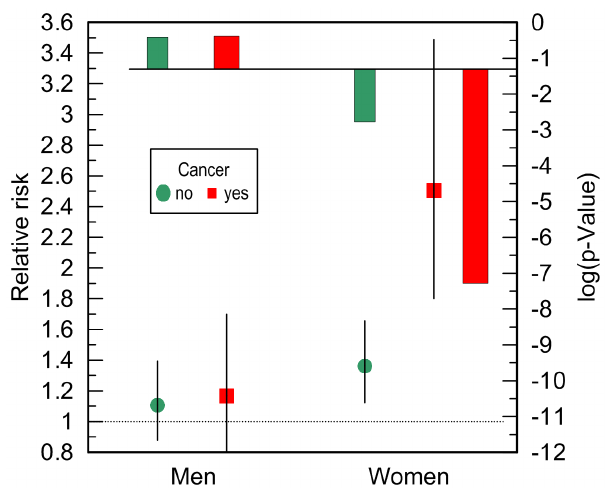
Figure 5. Cancer-stratified relative risks of death and log-base- 10-transformed p-values for the ApoE4 allele carriers com- pared to the non-carriers. The risks were evaluated in more homogeneous groups of individuals who died or were right censored at ages 70 to 95 years in the pooled sample of the FHS and FHSO. ‘‘No’’ indicates individuals who did not have non-skin cancers apart from prostate neoplasm in men or breast neoplasm in women. ‘‘Yes’’ indicates individuals who had non-skin cancers other than prostate neoplasm in men or breast neoplasm in women. The models were adjusted for birth cohorts, an indicator of the FHS or FHSO, and additive contribution of CVD and ND. The multiplicative interaction between ApoE and non-sex-specific cancer in women was highly significant (p=5.2 6 10 2 3 ). Thin bars show 95% confidence intervals. Exact numeric values for the estimates and sample size are given in Table 3 (non- prostate and non-breast). The solid horizontal line shows the conventional level of significance, i.e., log 10 (0.05)= 2